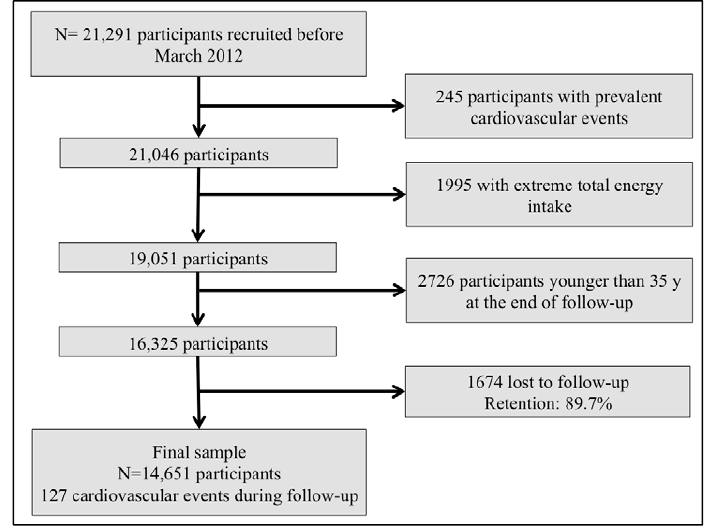
Figure 1. Flow chart of participants. The Seguimiento Universidad de Navarra (SUN) project (1999– 2014).